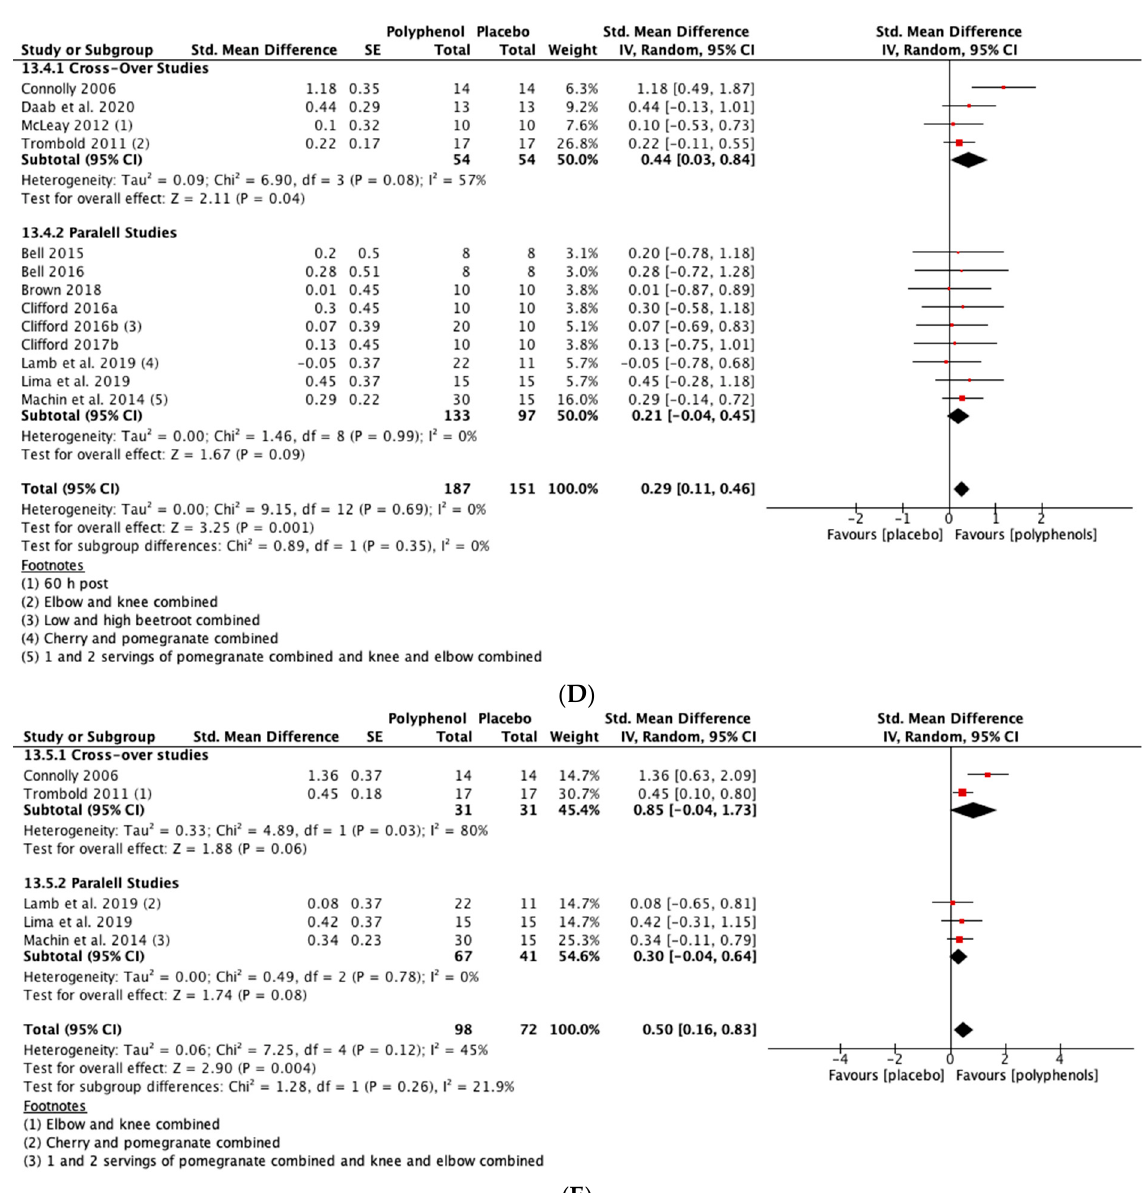
Figure 3. Effect of polyphenol-rich foods, juices and concentrates on recovery of maximal voluntary isometric contraction A ) immediately post-exercise; ( B ) 24 h; ( C ) 48 h; ( D ) 72 h; ( E ) 96 h.